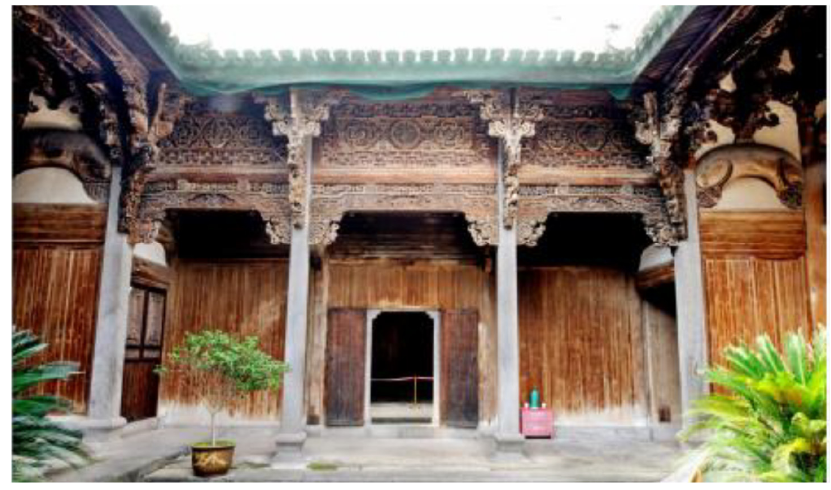
Figure 2. National level heritage “The Eightside Hall” in Huangshan